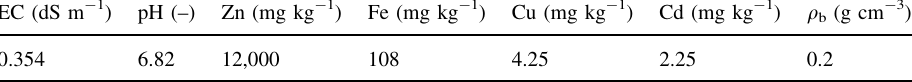
Table 1 Selected physical and chemical properties of crumb rubber (CR)